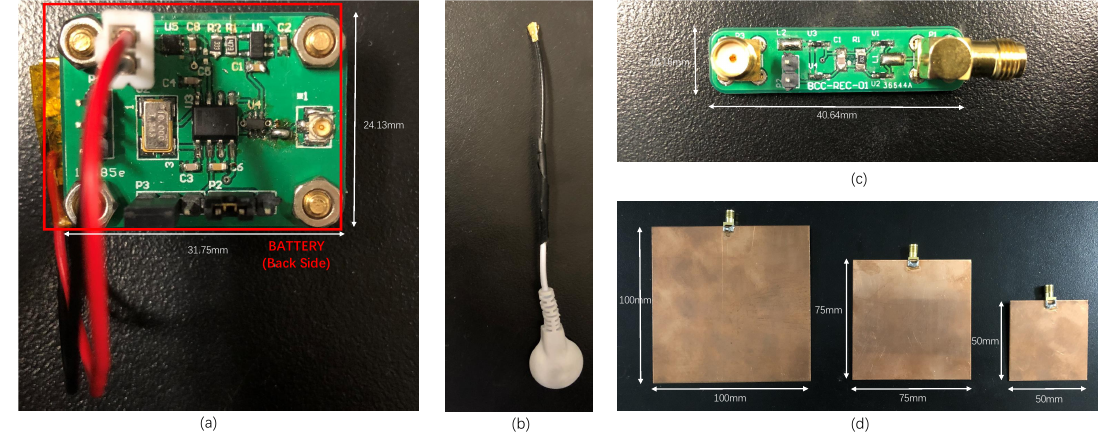
Figure 7. Implementations of BC-WPT. ( a ) Source PCB. ( b ) Signal wire of the source. ( c ) Harvester PCB. ( d ) Ground electrodes with three different